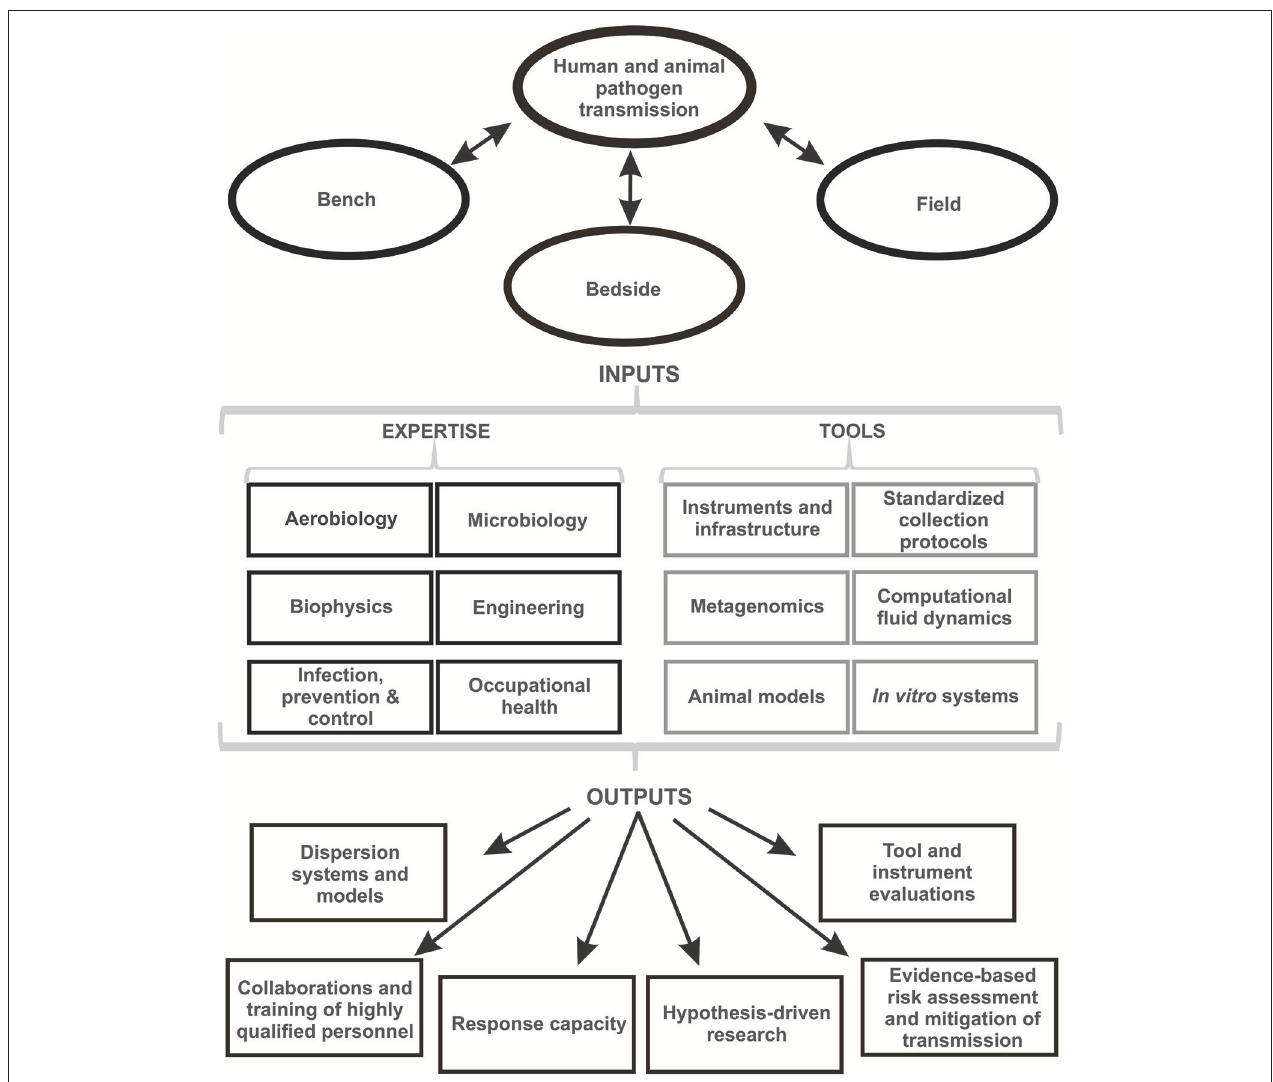
FIGURE 1 | Summary of the research fields, assets, and deliverables for collaborative bioaerosol